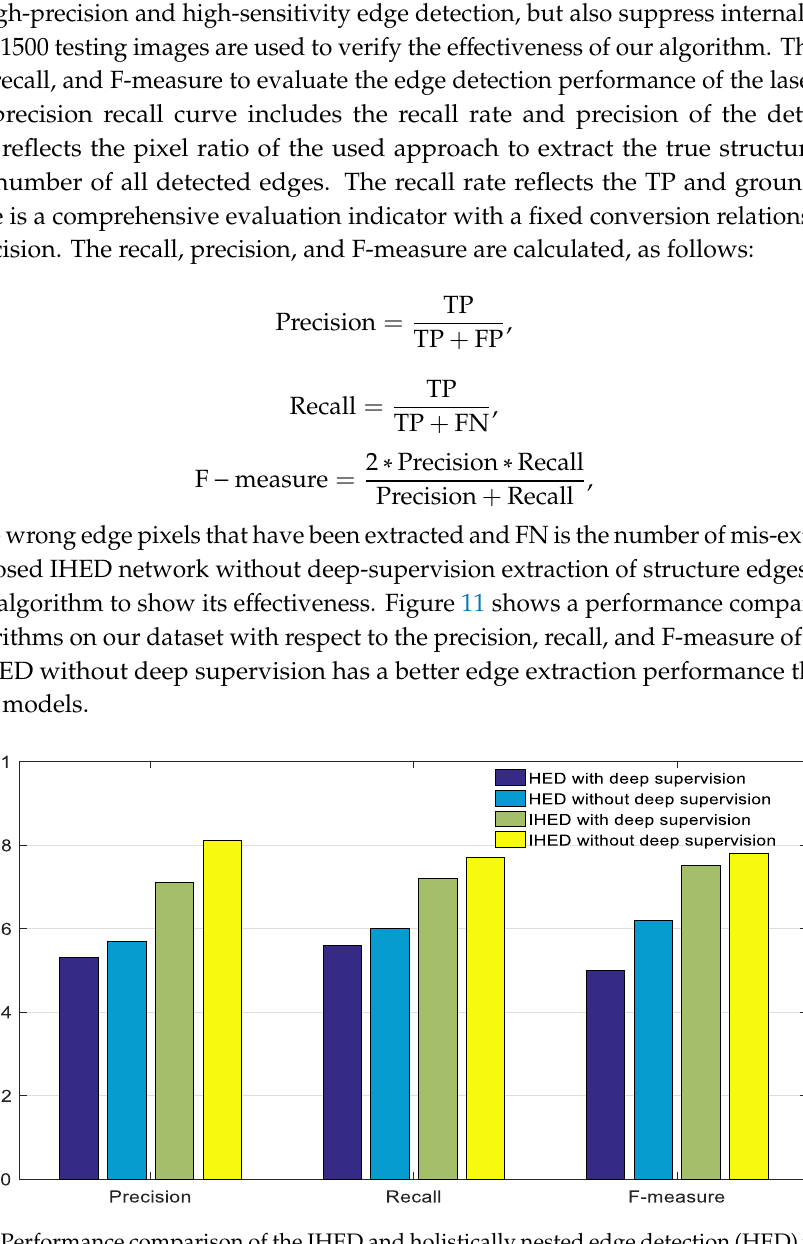
Figure 11. Performance comparison of the IHED and holistically nested edge detection (HED) networks with/without deep-supervision with respect to edge extraction.